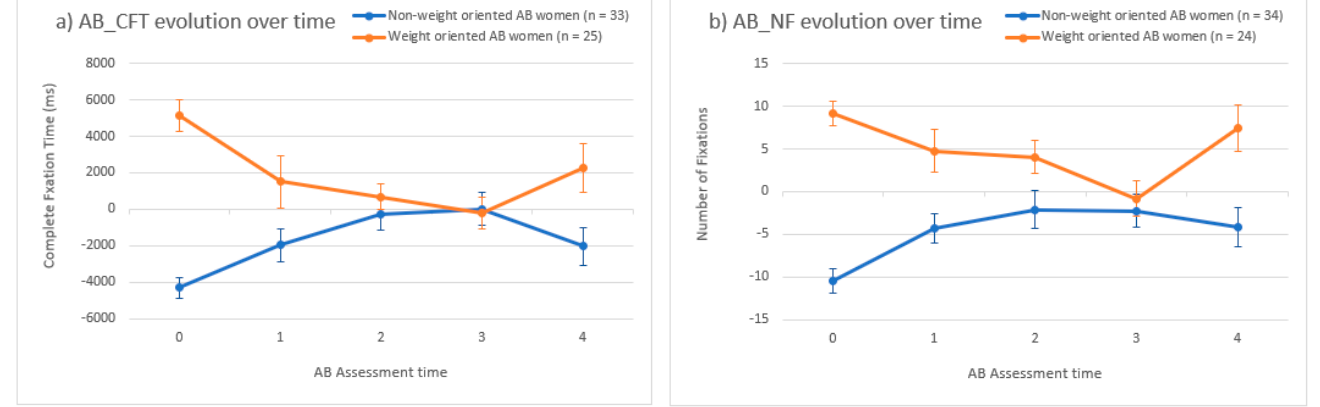
Figure 5. Body-related attentional bias evolution over the intervention. ( a ) Complete fixation time (AB_CFT); ( b ) Number of fixations (AB_NF). Note. Attentional bias (AB) means evolution over time based on ( a ) complete fixation time (AB_CFT); ( b ) number of fixations (AB_NF). ms = milliseconds. AB assessment time: 0 at baseline, 1, 2, 3 and 4 respectively after ABMT series 1, 2, 3 and 4. Error bars represent standard errors of the mean.